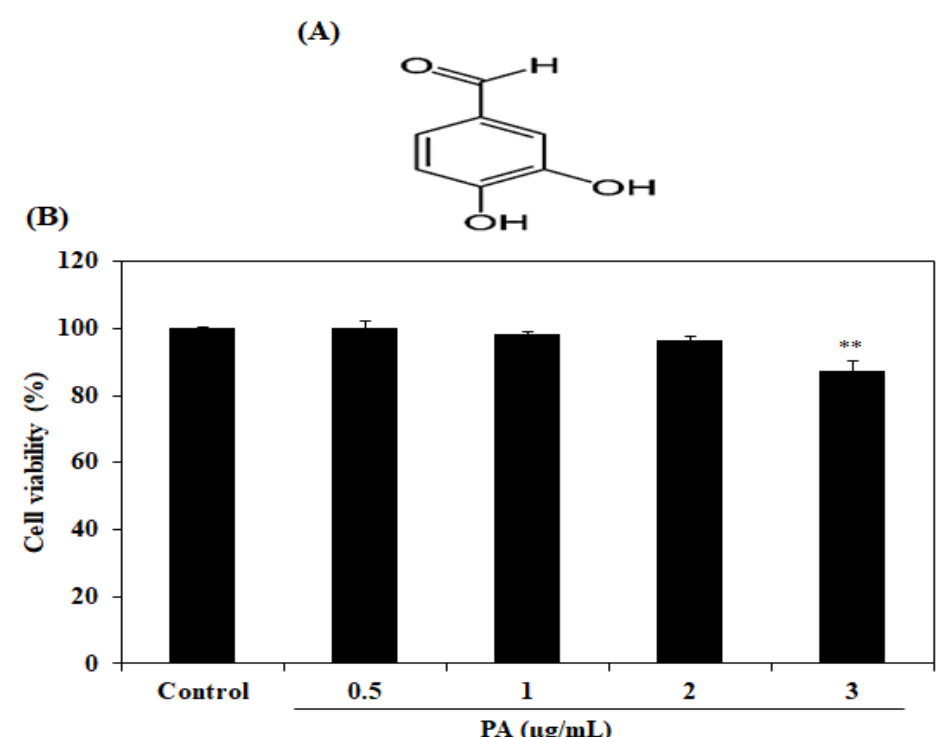
Figure 1. Chemical structure of PA ( A ). Effect of PA on the cell viability of HDF cells treated for 24 h ( B ). The cell viability was measured using an MTT assay. Values are expressed as the mean ± SD in triplicate experiments. ** p < 0.01 indicates a significant difference compared to the control group.